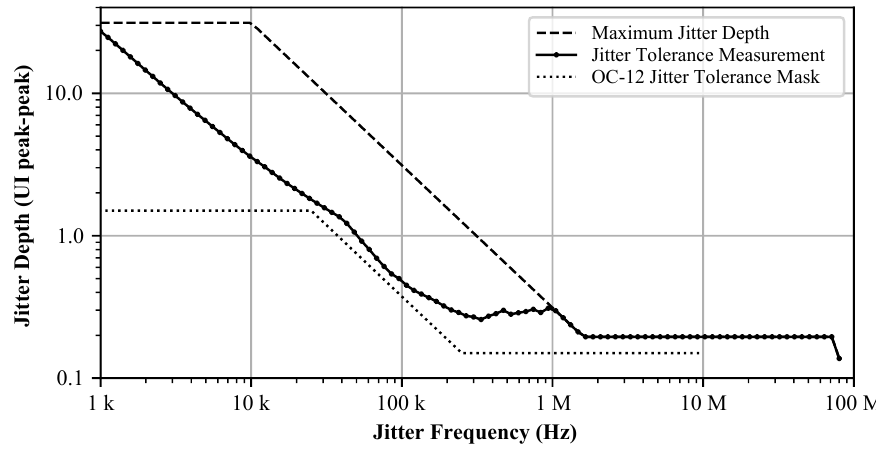
Figure 9. Closed-loop CDR jitter tolerance measurement obtained for a 320Mbits −1 input data rate. Jitter amplitude limits of the N4903B test setup are indicated with a dashed